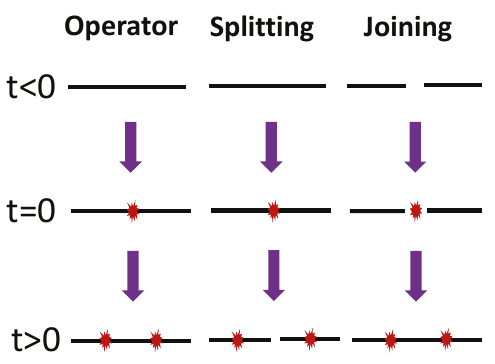
Figure 1 . The three local quenches are sketched: the local operator quench (left), the splitting local quench (middle), and the joining local quench (right) in two dimensional CFTs. The red points are locations where the energy density is very